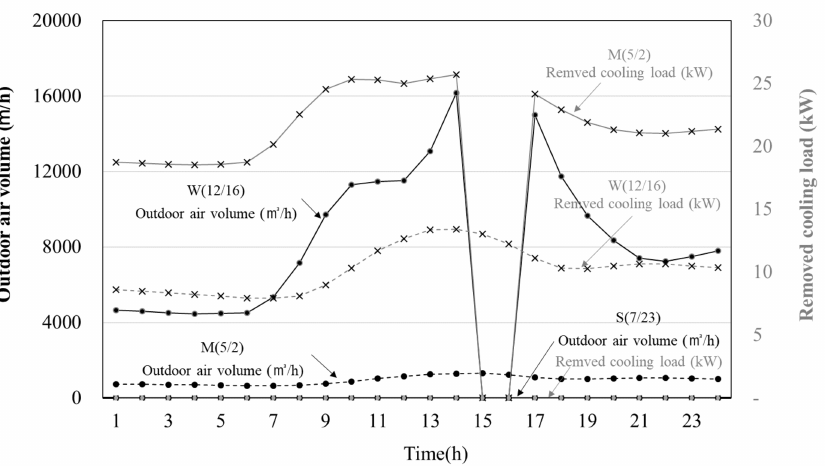
Figure 9. Daily variations in outdoor air volume and removed cooling load for representative